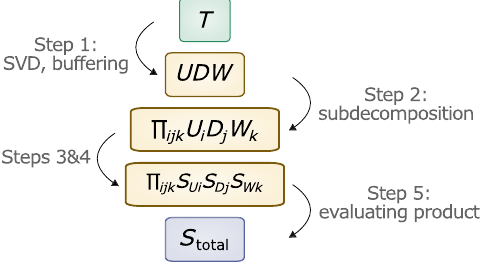
FIG. 3. Overview of the method. Starting with T , a singular value decomposition, followed by a padding with identity matrix elements to make all components the same size, provides the main components U , D , and W . In step 2, a further decomposition of U and W into simple blocks is found through the technique in Ref. [2] or [3], and D is written as a product of single-mode modulations. For each of these, a corresponding enlarged trans- formation is determined in steps 3 and 4. Finally, the overall transformation S is obtained as the product of all the total individual